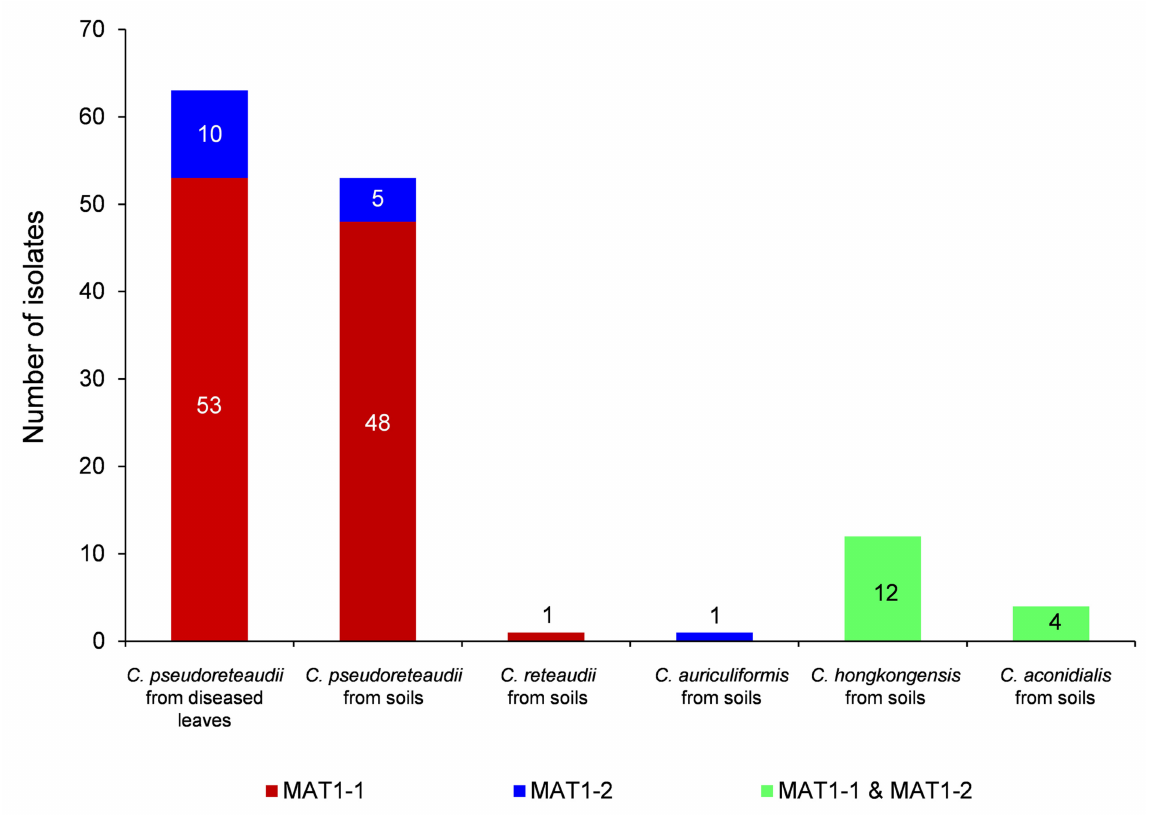
Figure 3. Bar graph showing the distribution of mating type idiomorphs (MAT1-1, MAT1-2, and MAT1-1 and MAT1-2) in five species of Calonectria